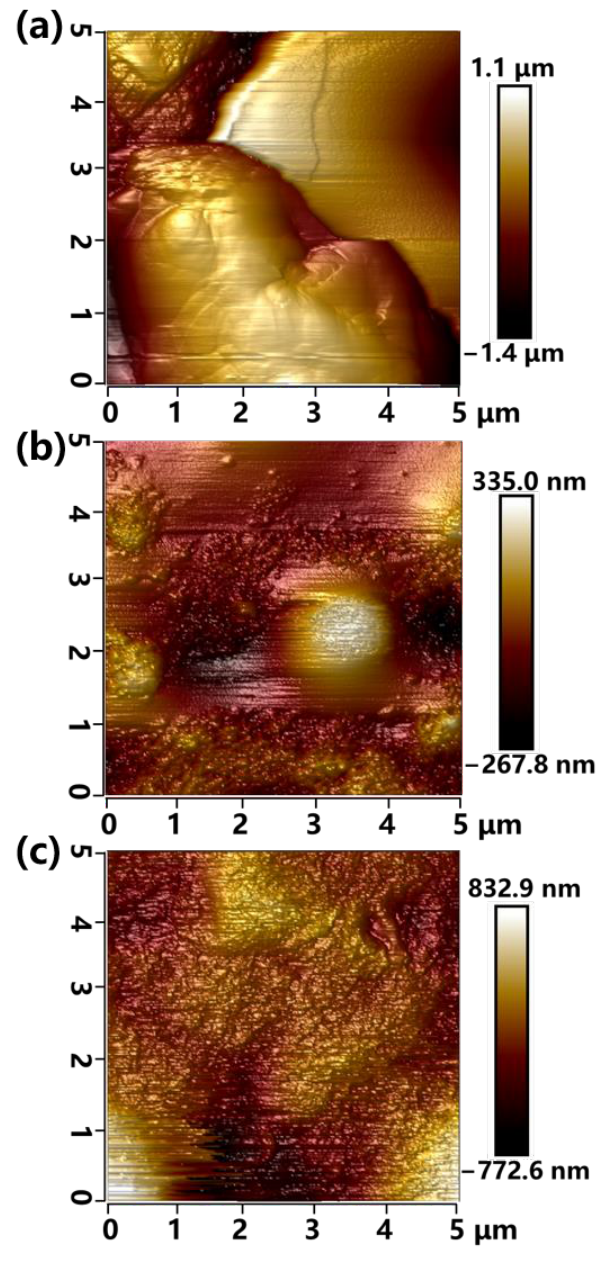
Figure 4. AFM 3D surface morphologies of ATH-90 SiR before NO 2 aging ( a ), ATH-0 SiR after NO 2 aging for 36 h ( b ), and ATH-0 SiR after NO 2 aging for 36 h ( c ).